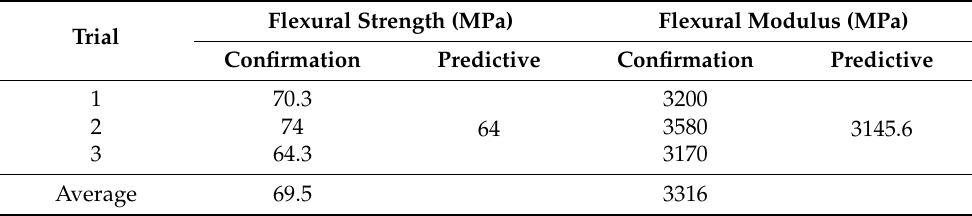
Table 9. Response results of the confirmation experiment and the prediction